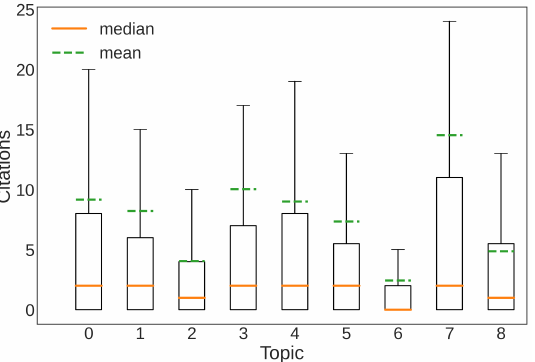
Figure 6. Boxplots obtained by the number of citations of the documents, grouped by